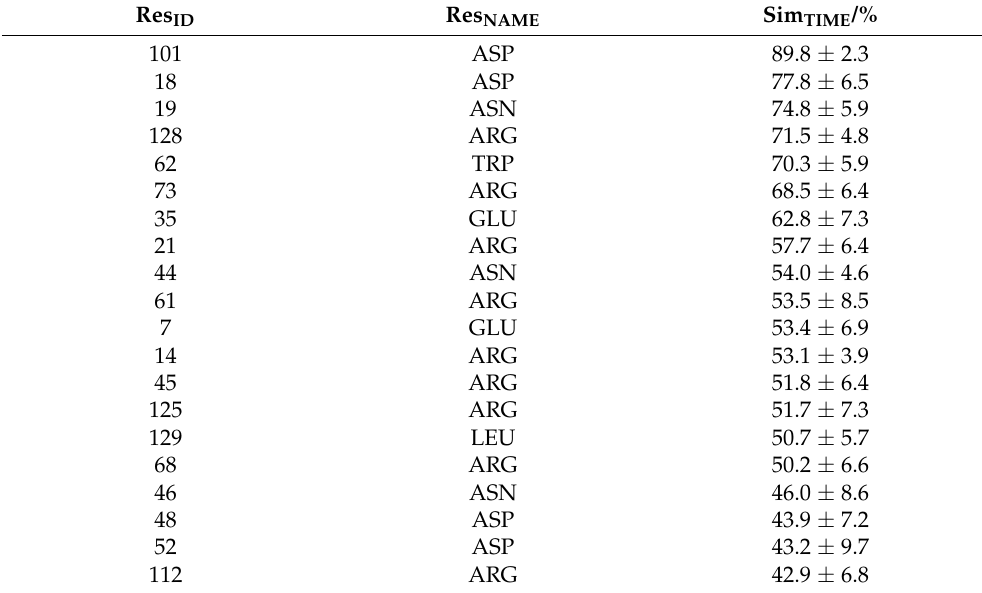
Table 1. List of specific amino acid residues near which (within 0.3 nm of distance) free arginines stay on average for the longest proportion of simulation time.